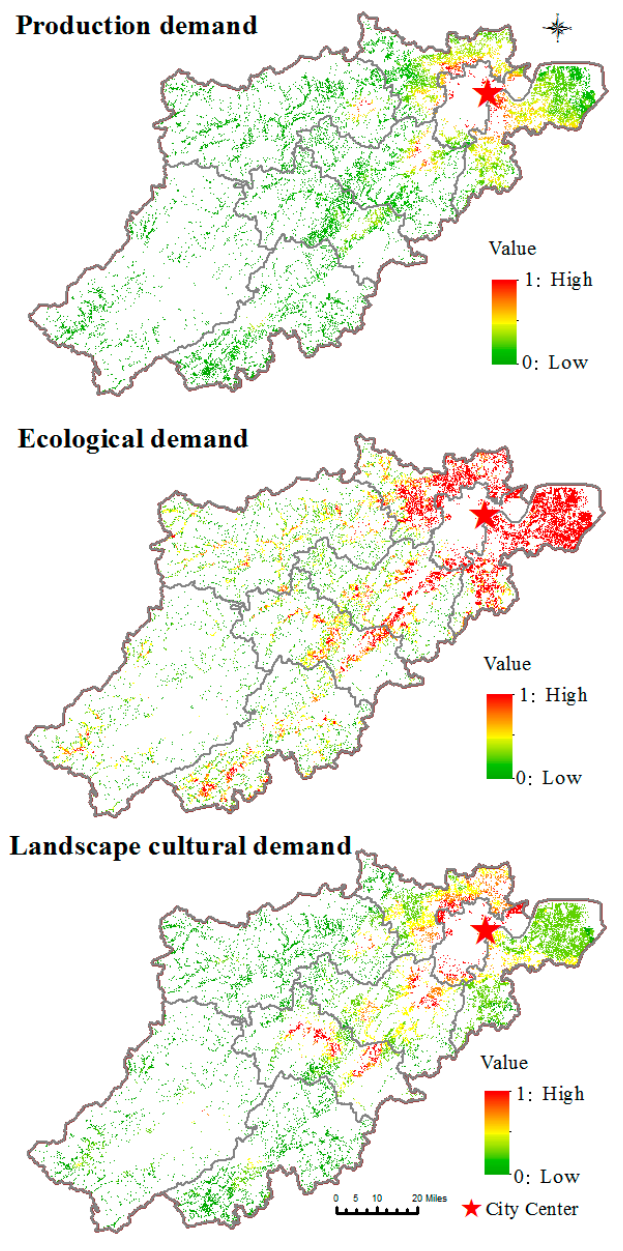
Figure 4. Demand patterns for farmland